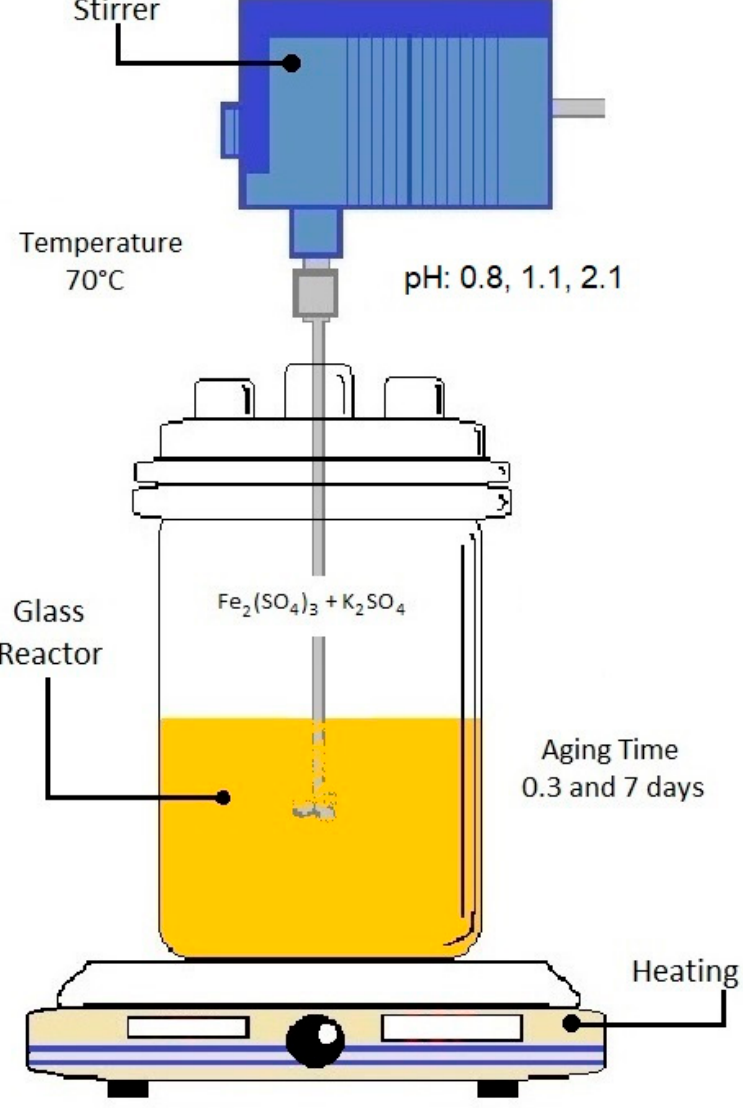
Figure 1. Experimental apparatus mounted to synthesize the potassium jarosite.